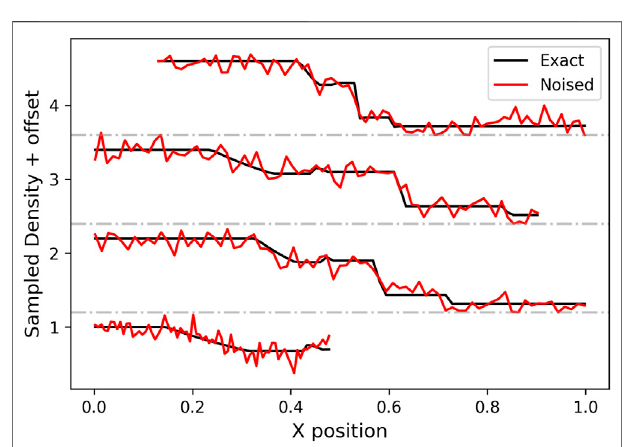
FIGURE 9 | Sampled ρ data for each of the four trajectories across the Brio-Wu space-time domain, plotted as a function of X coordinate. The red line is the same data with Gaussian noise added (mean (cid:1) 0, standard deviation (cid:1) 0.1).